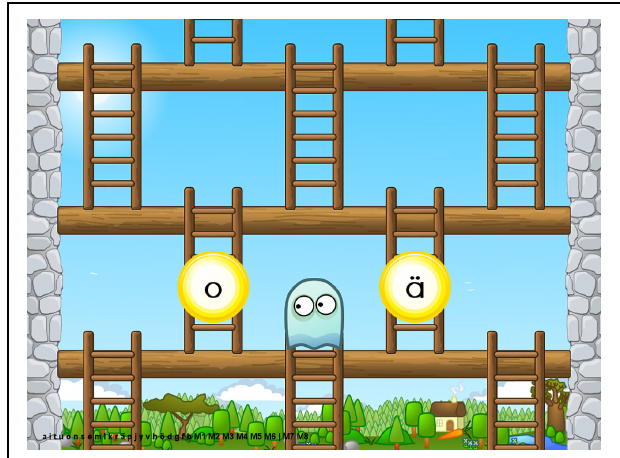
FIGURE 1 | A screenshot of a GraphoGame (GG) task in which the child is expected to choose the letter matching the letter sound. In case of a correct response, the game character climbs the ladder and falls down the ladder when the response is